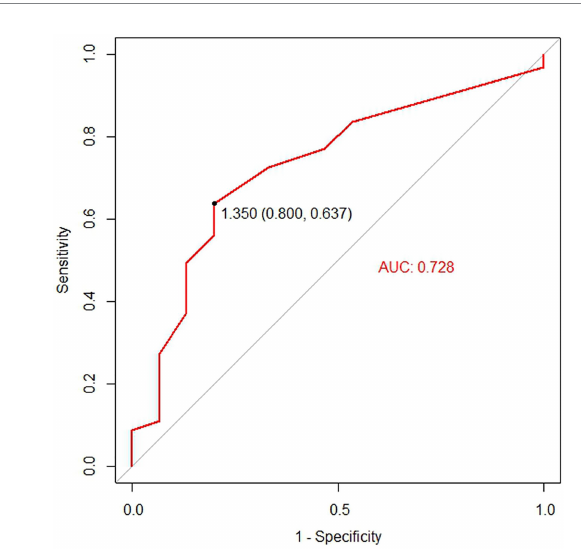
FIGURE 3 The receiver operating characteristic (ROC) analysis for the predictive value of vein diameter for functional maturation of the arteriovenous fistula (AVF). The black point on the ROC curve indicates the cutoff vein diameter at which optimal sensitivity and specificity were reached.